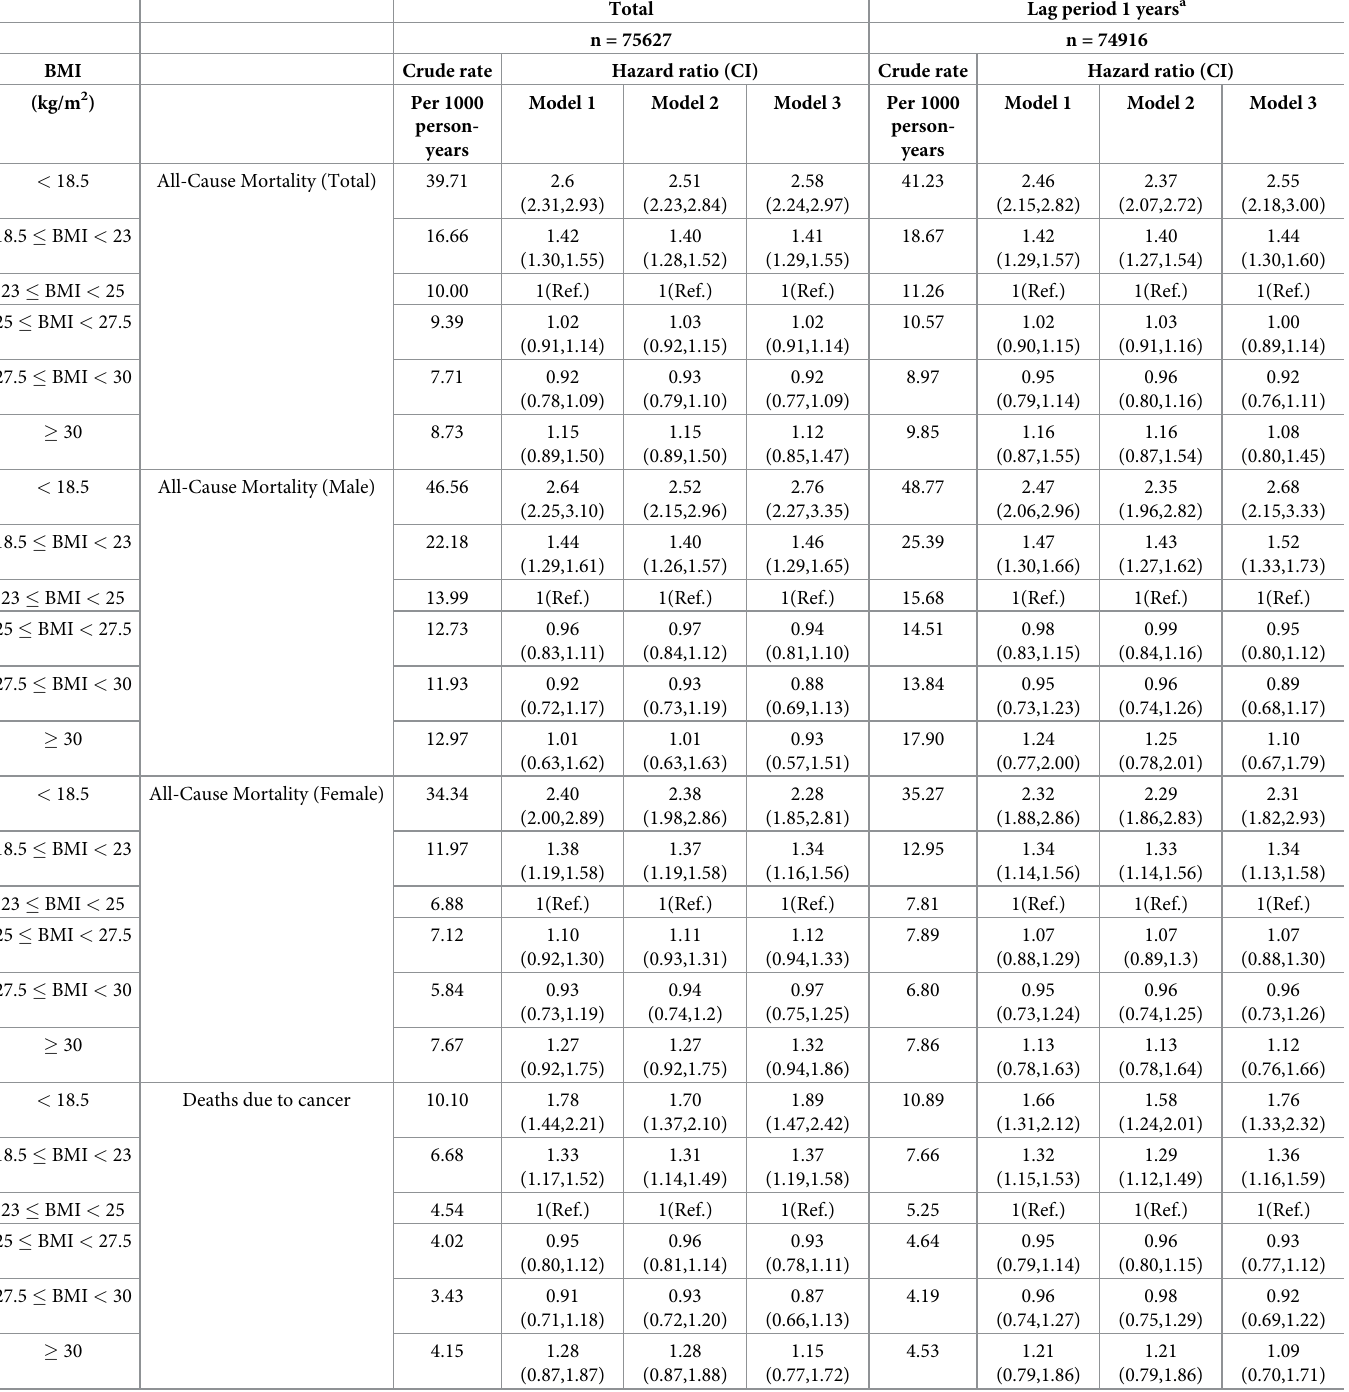
Table 2. Association between body mass index and all-cause and cause-specific mortality.